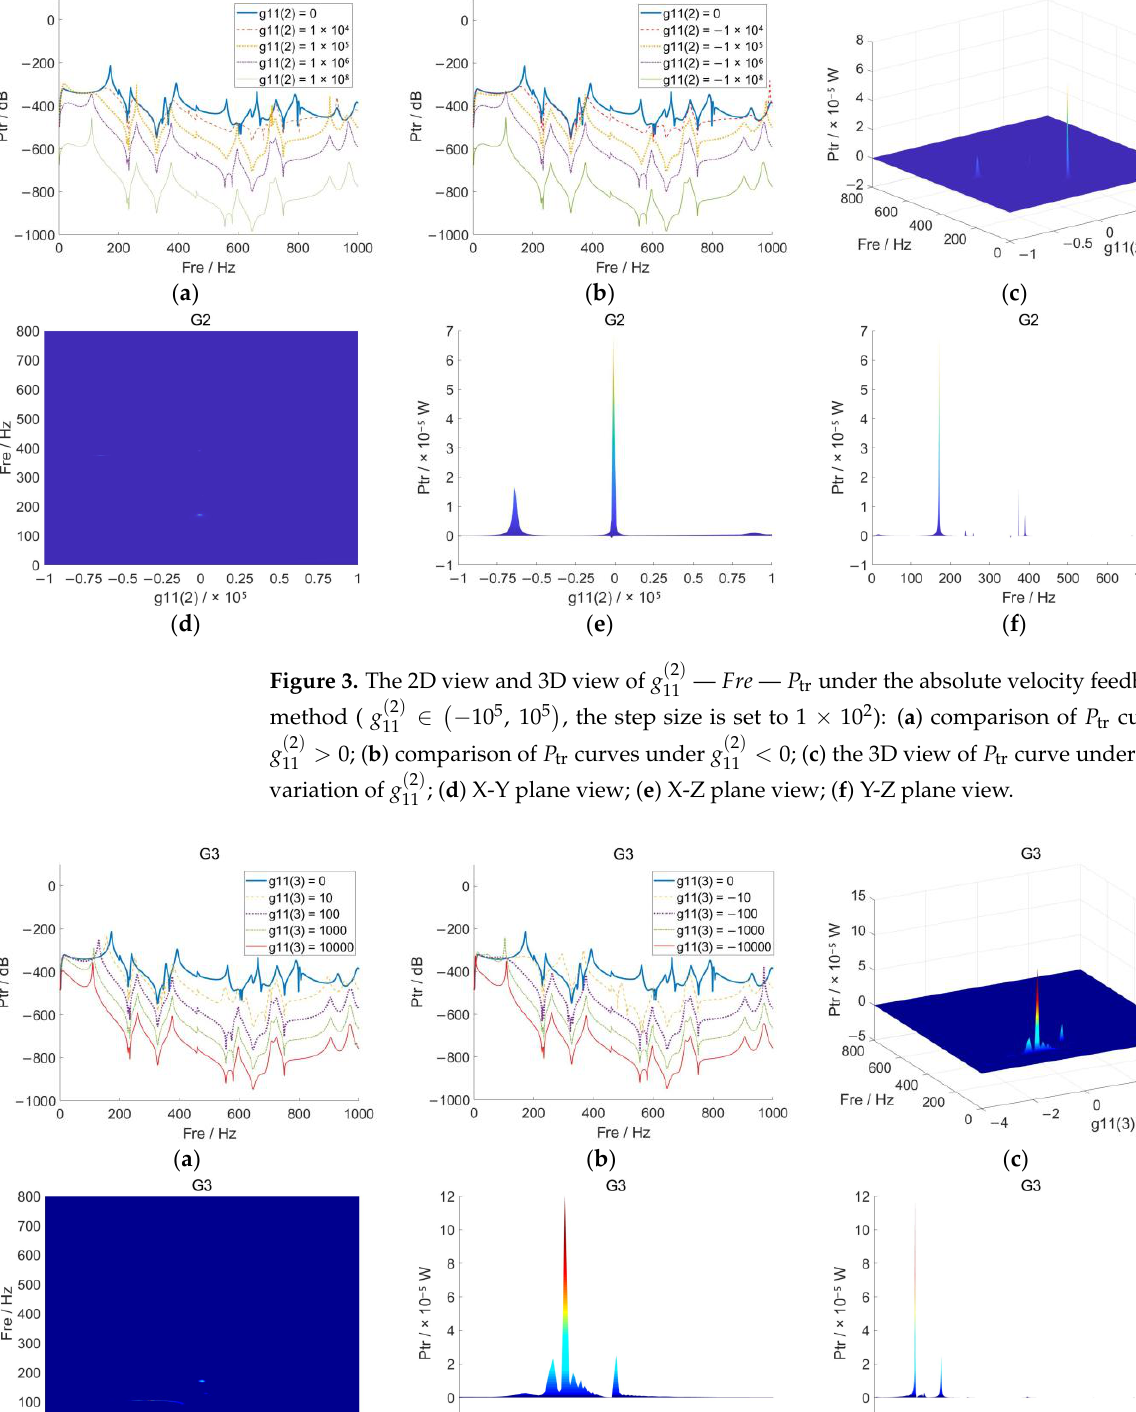
P under the absolute displacement feedback g — Fre — 11 tr P curves under tr P curves under ( ) 1 P curve under continuous 0 g  ; ( c ) the 3D view of 11 tr tr